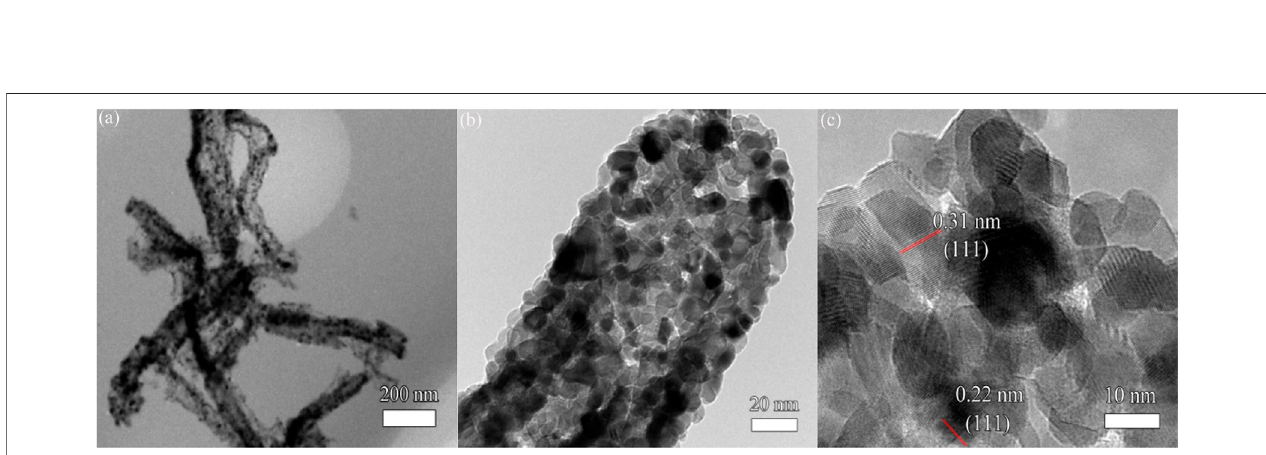
FIGURE 6 | (A) TEM image, (B) enlarged TEM image, and (C) HRTEM image of Ag/CeO 2 fi ber membrane with an Ag/CeO 2 molar ratio of